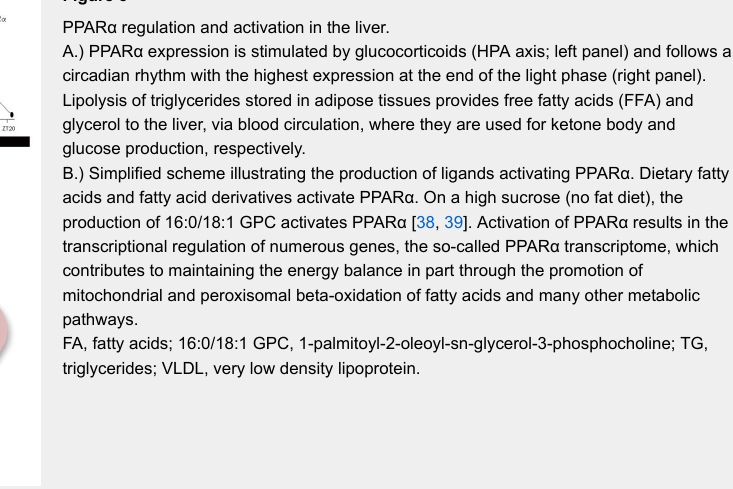
PPARα regulation and activation in the liver. A.) PPARα expression is stimulated by glucocorticoids (HPA axis; left panel) and follows a circadian rhythm with the highest expression at the end of the light phase (right panel). Lipolysis of triglycerides stored in adipose tissues provides free fatty acids (FFA) and glycerol to the liver, via blood circulation, where they are used for ketone body and glucose production, respectively. B.) Simplified scheme illustrating the production of ligands activating PPARα. Dietary fatty acids and fatty acid derivatives activate PPARα. On a high sucrose (no fat diet), the production of 16:0/18:1 GPC activates PPARα [38, 39]. Activation of PPARα results in the transcriptional regulation of numerous genes, the so-called PPARα transcriptome, which contributes to maintaining the energy balance in part through the promotion of mitochondrial and peroxisomal beta-oxidation of fatty acids and many other metabolic pathways. FA, fatty acids; 16:0/18:1 GPC, 1-palmitoyl-2-oleoyl-sn-glycerol-3-phosphocholine; TG, triglycerides; VLDL, very low density lipoprotein.